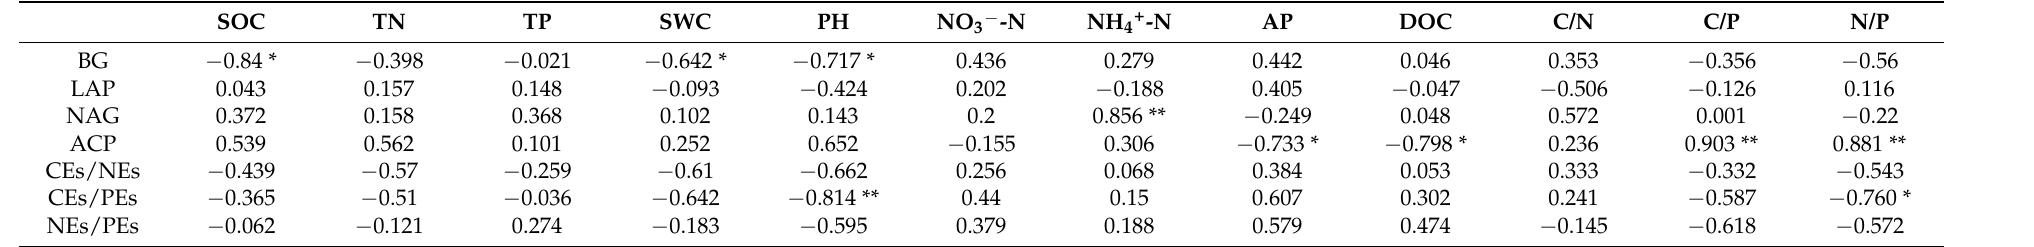
Table A1. Correlation analysis of soil enzyme activities and environmental factors.